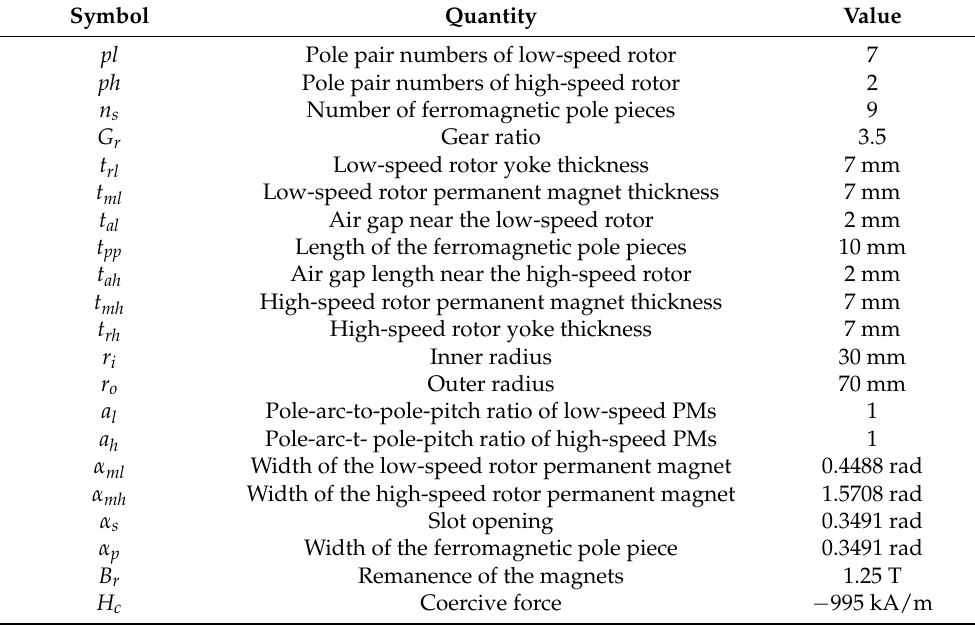
Table 1. Parameters of the AFMG *. Symbol Quantity Value pl Pole pair numbers of low-speed rotor 7 ph Pole pair numbers of high-speed rotor 2 Number of ferromagnetic pole